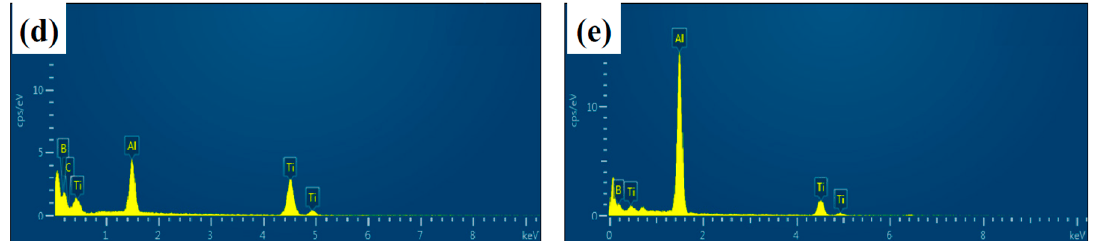
Figure 2. XRD pattern and FESEM micrographs of Al-TiB 2 /TiC in situ composites: ( a ) XRD pattern; ( b , c ) Microstructures at low and high magnification; ( d , e ) EDS point analysis for the particles.